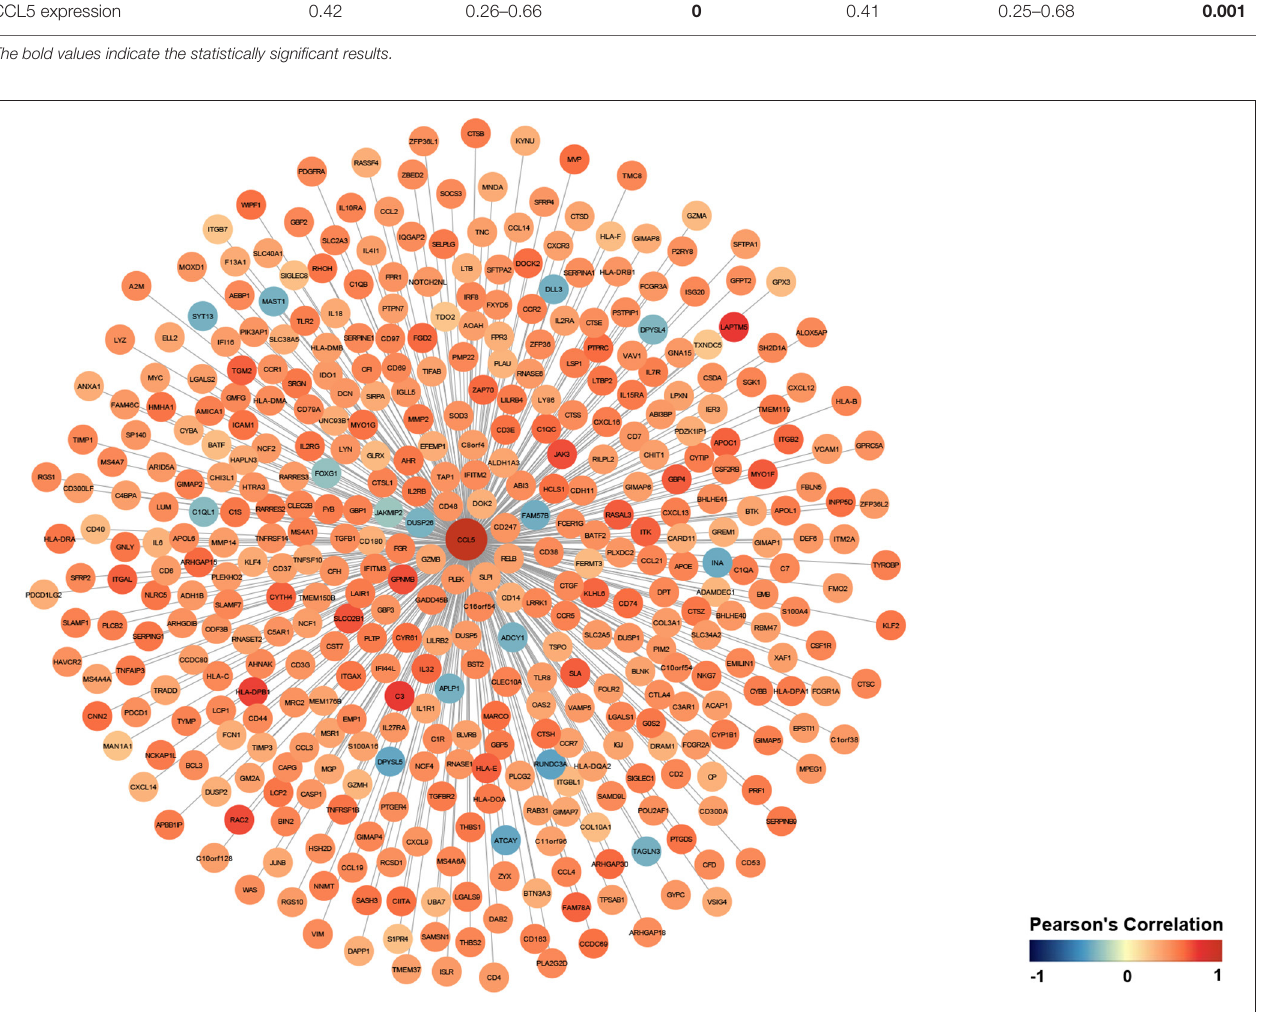
FIGURE 3 | Genes co-expressed with